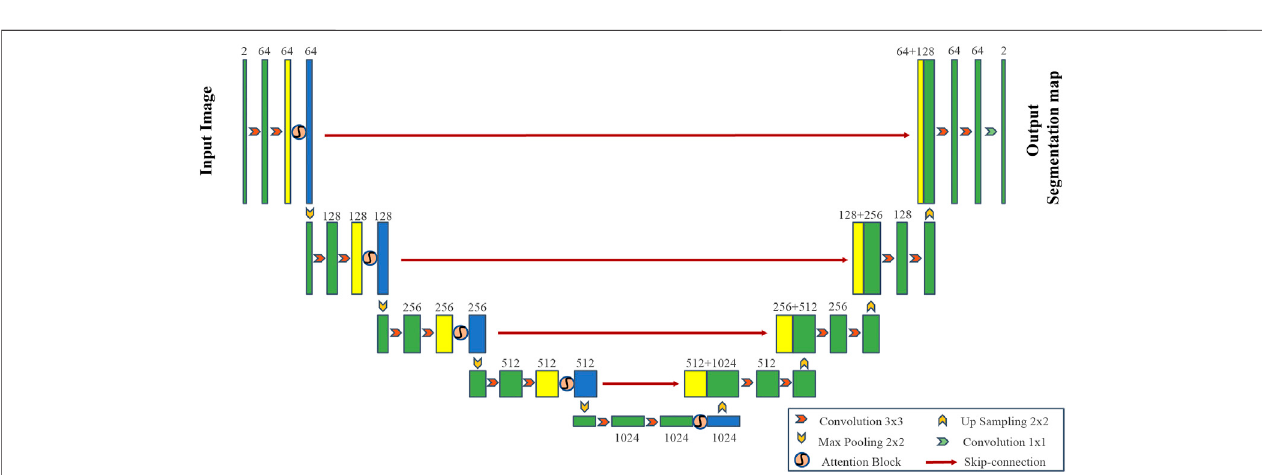
FIGURE 4 | CBAM_UNet